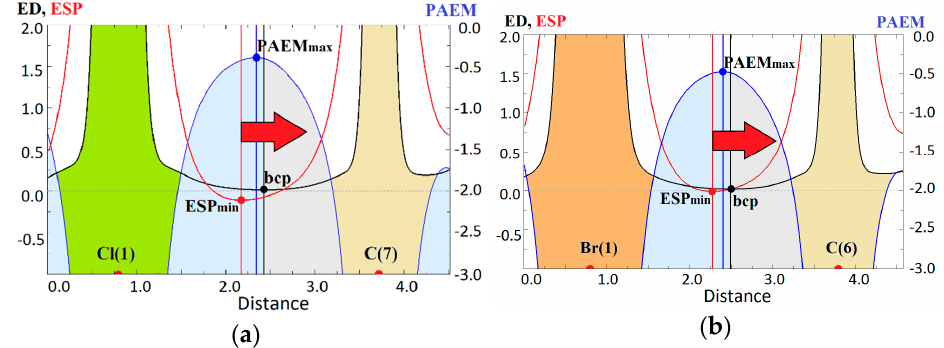
Figure 7. Potential acting on an electron in a molecule, а .u., (blue), electrostatic potential, а .u., (red) and electron density, а .u., (black) along the tetrel bond in ( a ) ZENJAD and ( b ) FADXIR complexes.